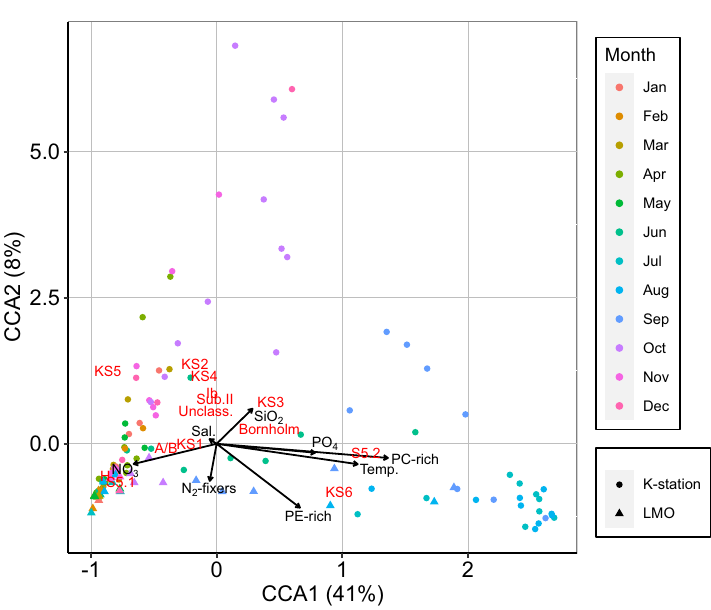
Figure 4. CCA analysis showing the relationships between environmental variables and picocyanobacterial community composition. Only variables that are significant are